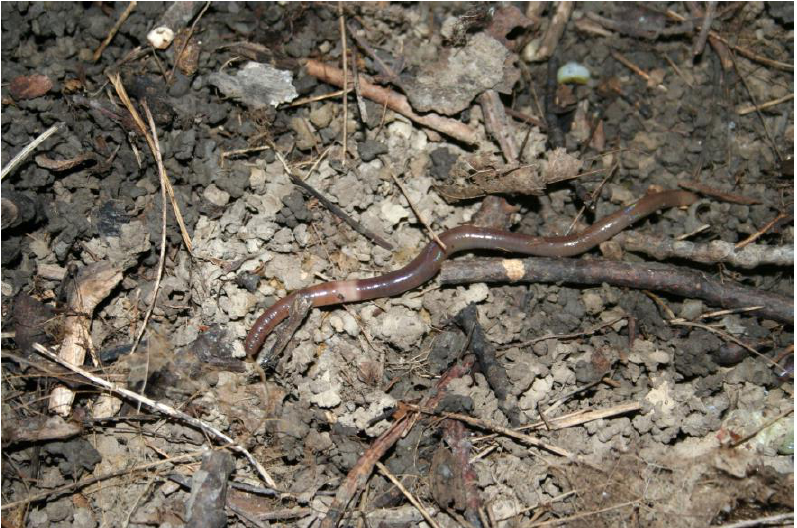
Figure 1. A. agrestis on its casting layer. Scale reference: Earthworm diameter is 4 mm.